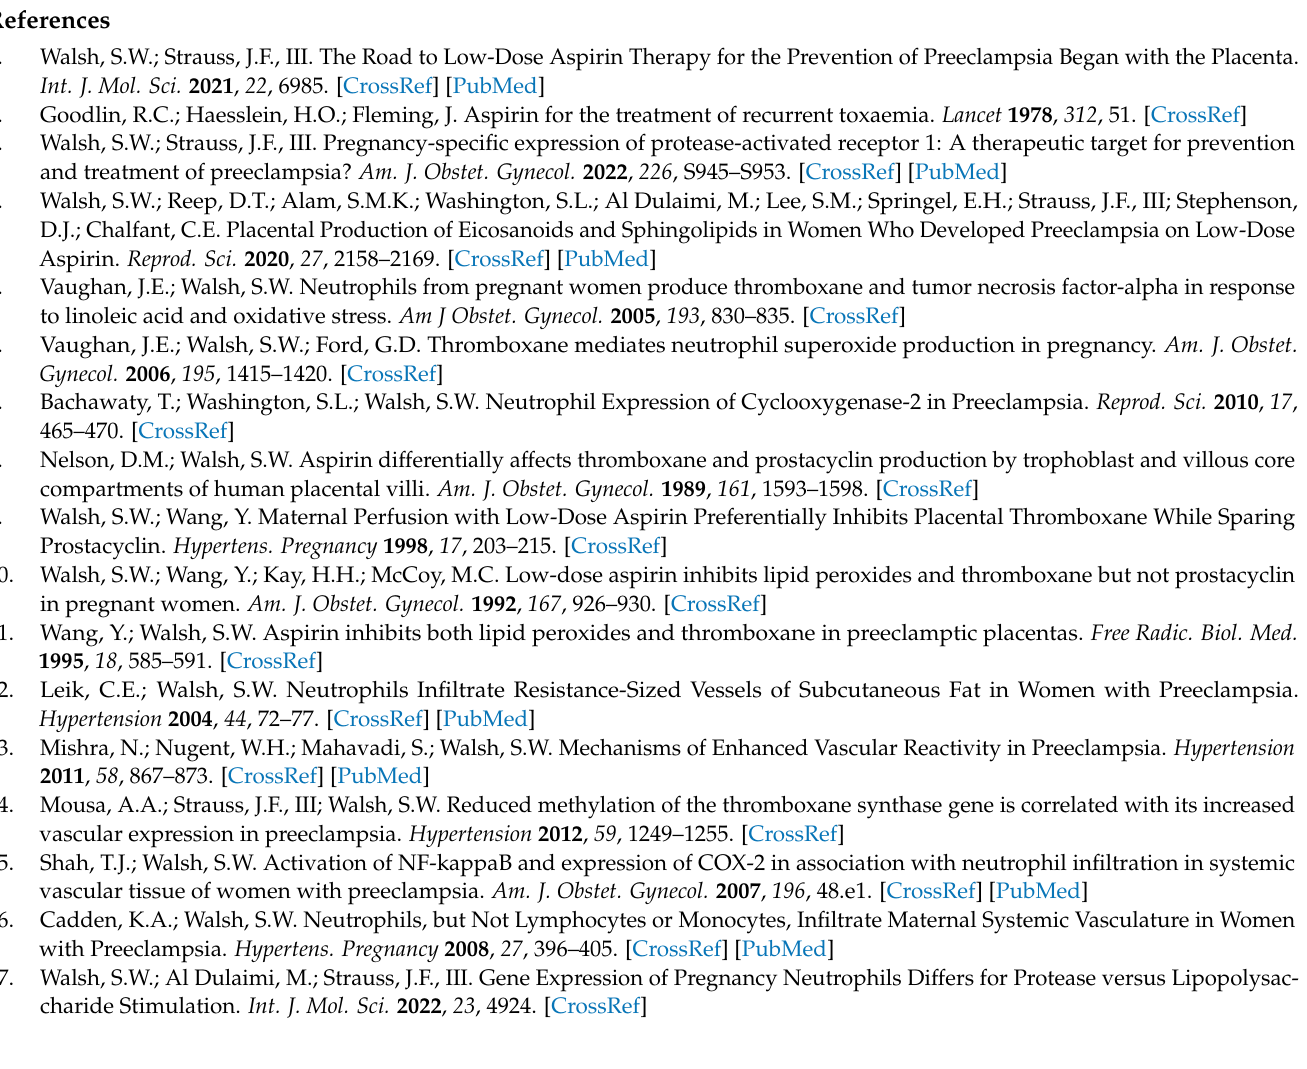
Figure A2. Summary of the clinical and pathologic manifestations of preeclampsia that can be explained by protease activation of PAR-1. (Modified from Ref. [1], Walsh, Strauss, Int J Mol Sci, 2021;22:6985 and Ref. [3], Walsh, Strauss, Am J Obstet Gynecol, 2022;226:S945-s53).